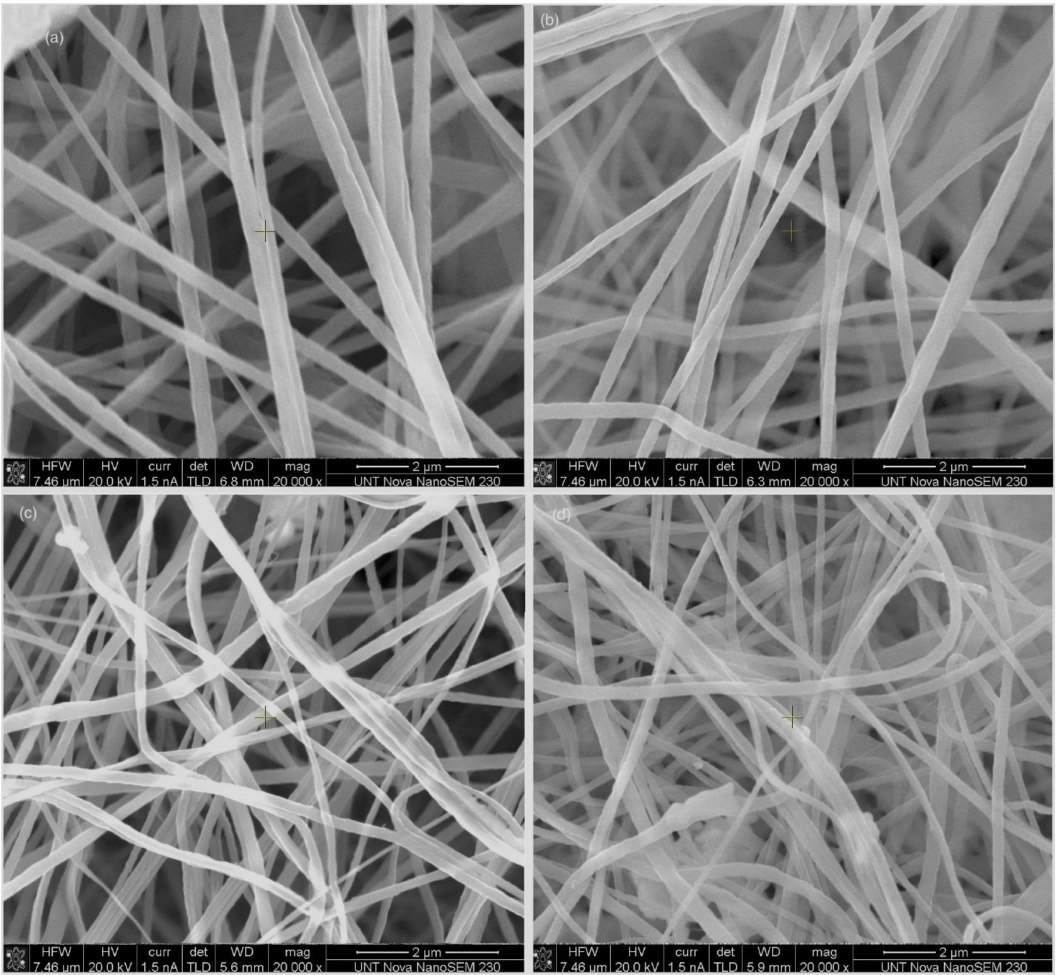
Figure 2. Scanning electron microscopy (SEM) images of ( a ) the polyvinylfluoride (PVDF) fiber, ( b ) 1% ZnO-PVDF fiber, ( c ) 3% ZnO-PVDF fiber, and ( d ) 5% ZnO-PVDF fiber.